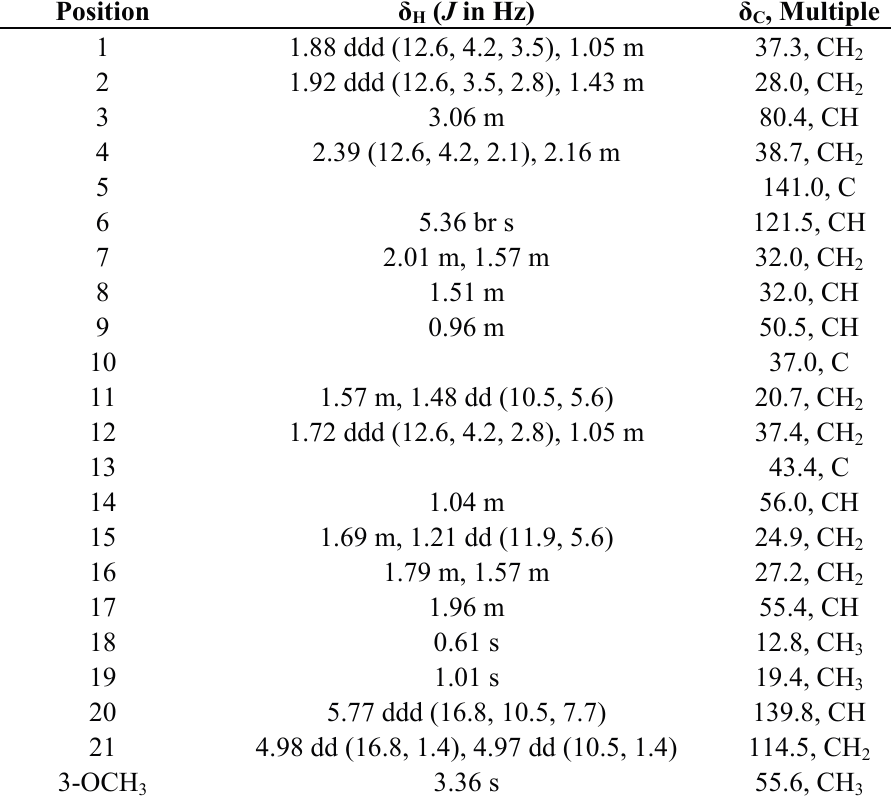
) NMR data for steroid 1 3